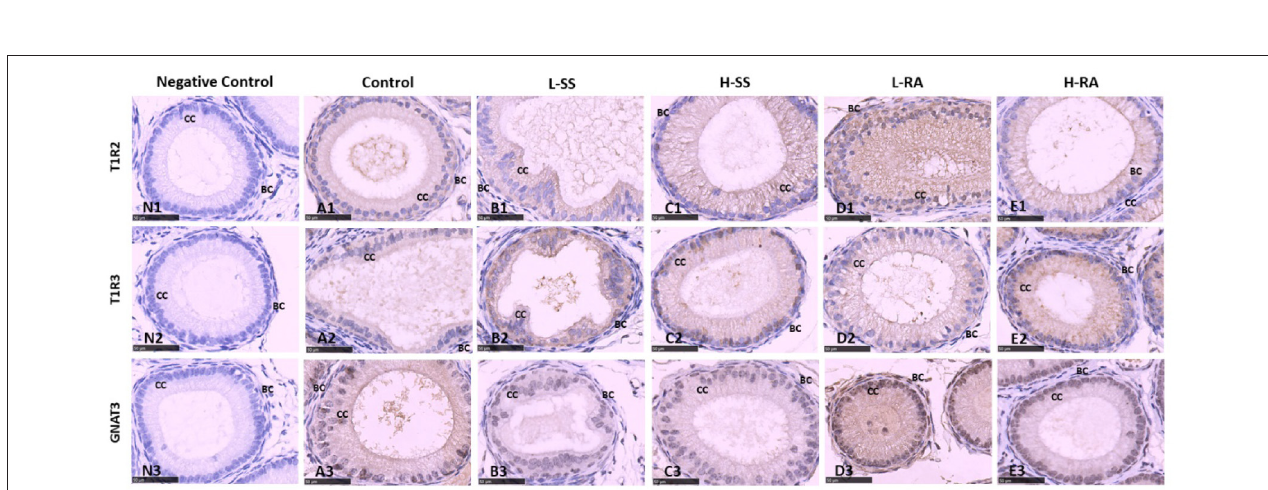
FIGURE 7 | Effect of dietary non-nutritive sweetness drinking on immunolocalization of the sweet-tasting molecules T1R2 (7A1–E1) , T1R3 (7A2–E2) , and GNAT3 (7A3–E3) in the efferent duct of the epididymis in male guinea pigs. Animals in the control, L-SS, H-SS, L-RA, and H-RA groups were supplied water solution with normal water, 1.5mM sodium saccharin, 7.5mM sodium saccharin, 0.5mM rebaudioside A, and 2.5mM rebaudioside A for 28 days, respectively. Tissues were sectioned at 4 µ m and immunostained with primary antibody to T1R2, T1R3, and GNAT3 proteins, and negative control was performed with NRS instead of